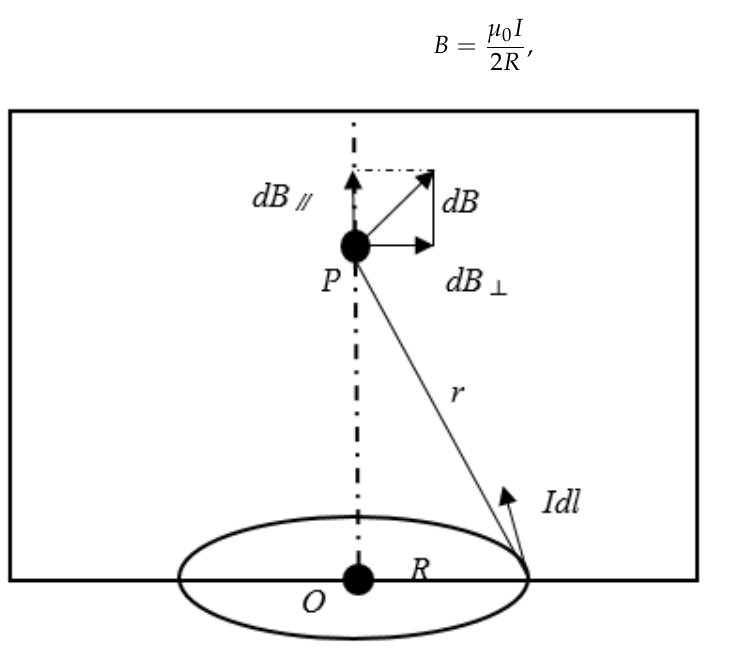
Figure 2. Magnetic field on the circular current-carrying conductor